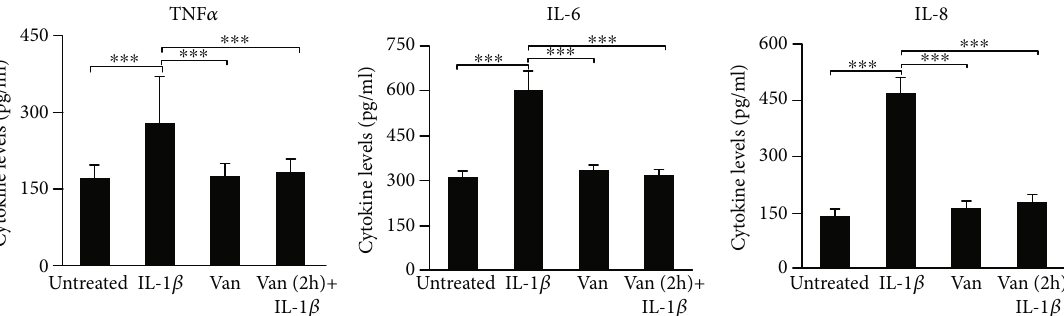
Figure 2: TNF- α , IL-6, and IL-8 levels in HGF cell culture supernatant. The mean values ± SD were reported, ∗∗∗ p < 0 : 001 . All experiments were repeated in